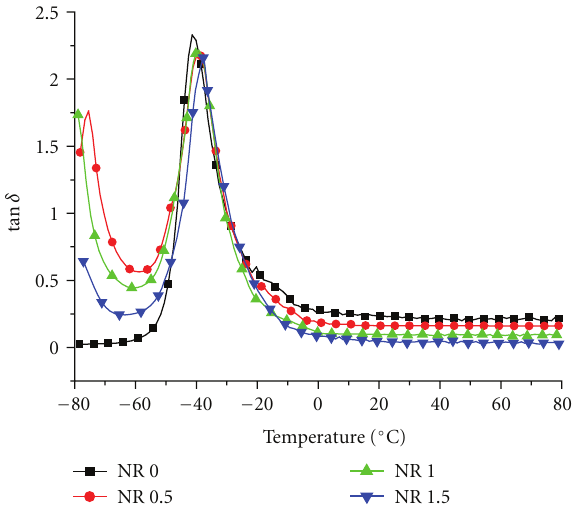
Figure 4: Dependence of storage modulus on temperature and on the amount of filler introduced.